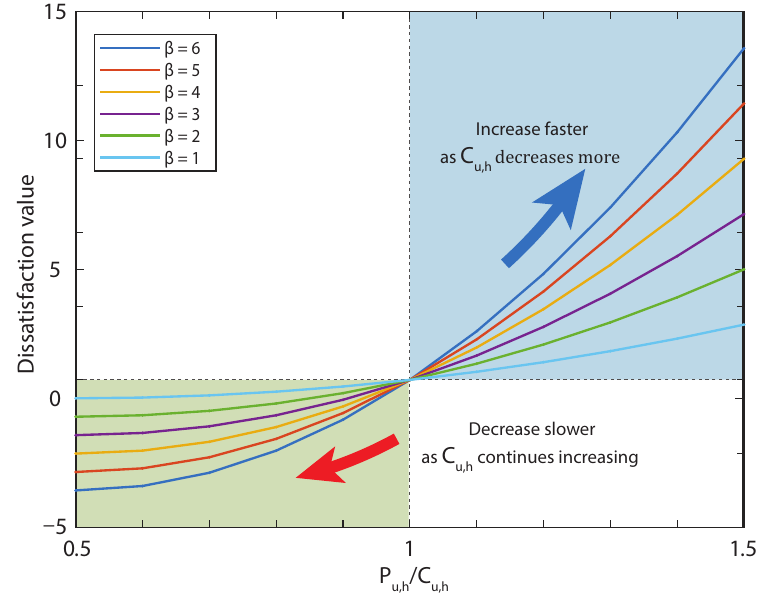
Figure 6. Bidirectional dissatisfaction